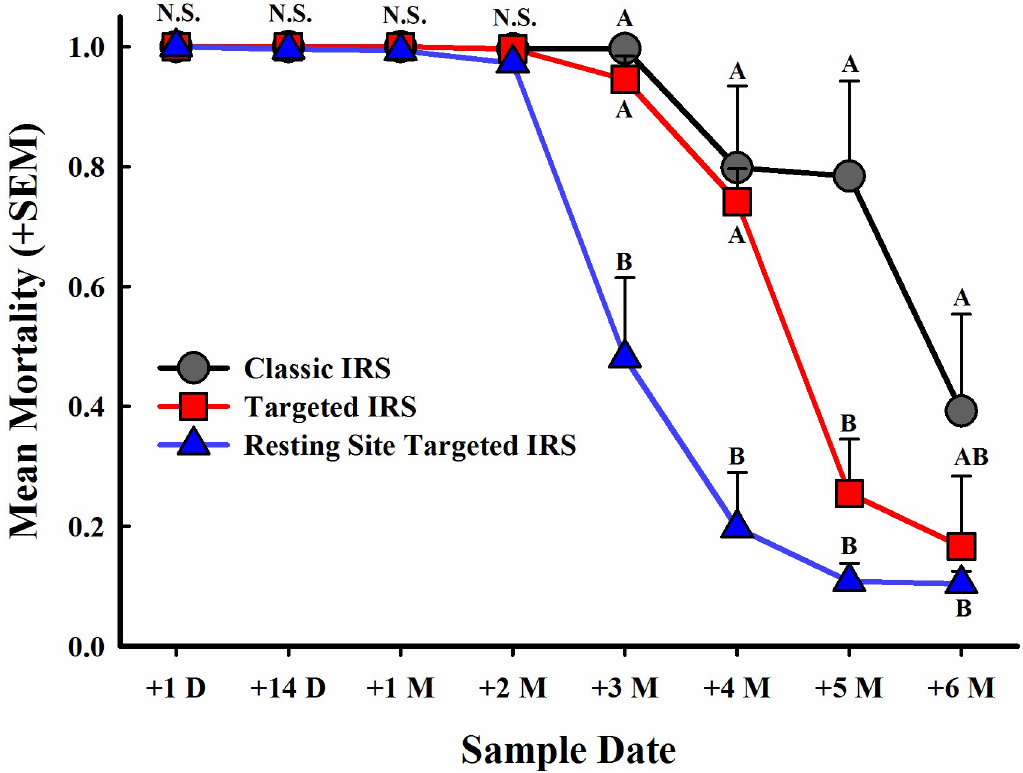
Fig 2. Mortality of pyrethroid-resistant Ae . aegypti by IRS application method using bendiocarb over time. Symbols denote sample means and error bars are the standard error of the mean. Letters denote significant differences among IRS application methods within sample